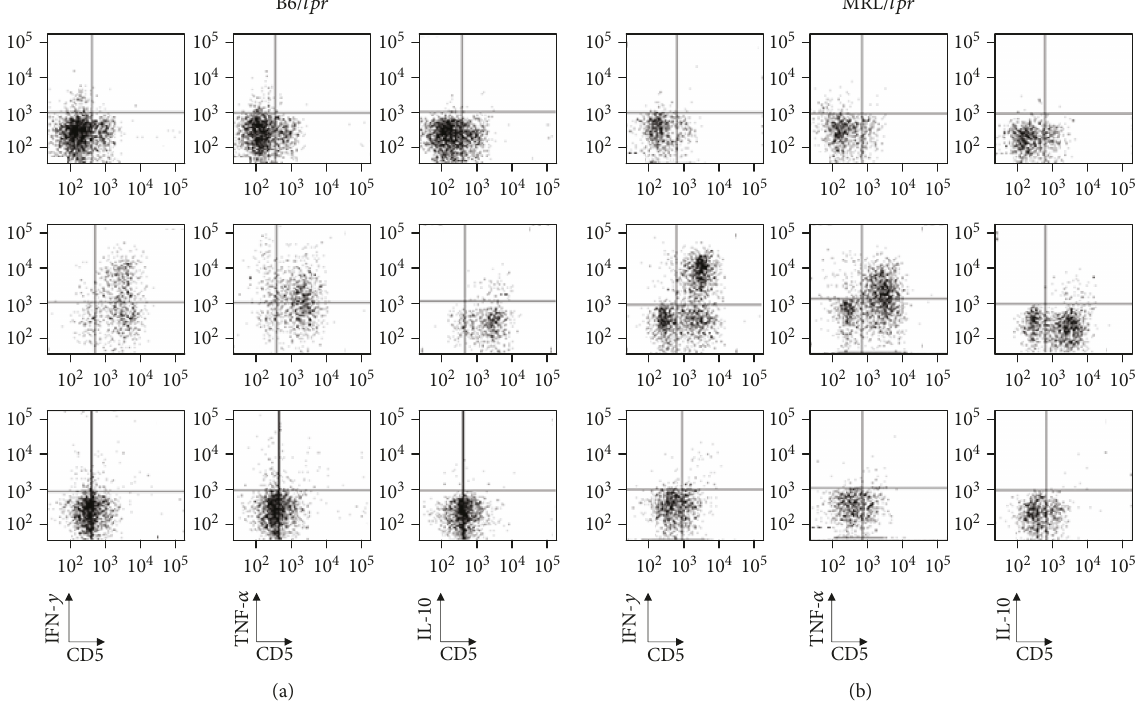
Figure 6: Intracellular staining for the detection of IFN γ , TNF α , and IL-10. Mononuclear cells isolated from the peripheral blood were cultured with LPS (10 μ g/ml), PMA (50 ng/ml), ionomycin (500ng/ml), and monensin (2 μ M) for 5 h. After culture, the cells were stained with appropriate fl uorescence antibodies to detect cell-surface markers, fi xed, and permeabilized. The cells were also stained intracellularly with APC-conjugated anti-IFN γ , anti-TNF α , and anti-IL-10. After washing, the cells were immediately subjected to fl ow cytometric analysis. (a) Representative results of the fl ow cytometry of the B6/ lpr mice showing intracellular staining of IFN γ (left column), TNF α (middle column), and IL-10 (right column) of B cells (upper line), T cells (middle line), and CD3+B220+ cells (lower line). (b) Representative results of fl ow cytometry of the MRL/ lpr mice showing intracellular staining of IFN γ (left column), TNF α (middle column), and IL-10 (right column) of B cells (upper line), T cells (middle line), and CD3+B220+ cells (lower